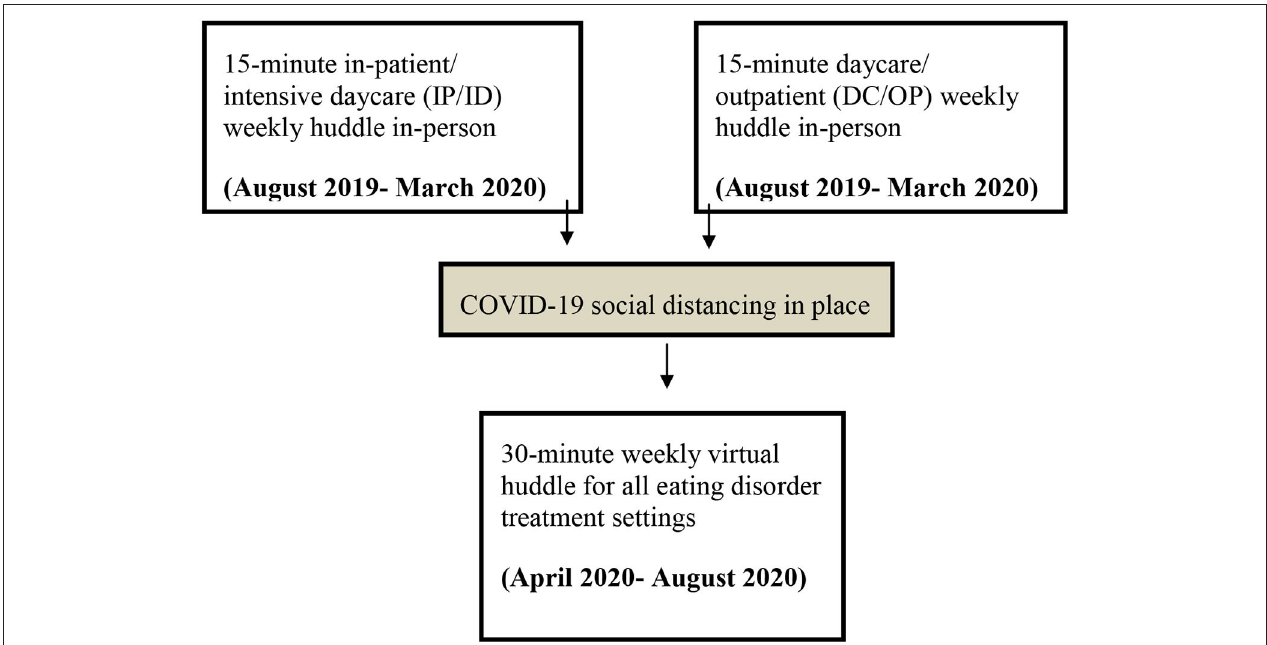
FIGURE 1 | A flow diagram showing the huddle structure over